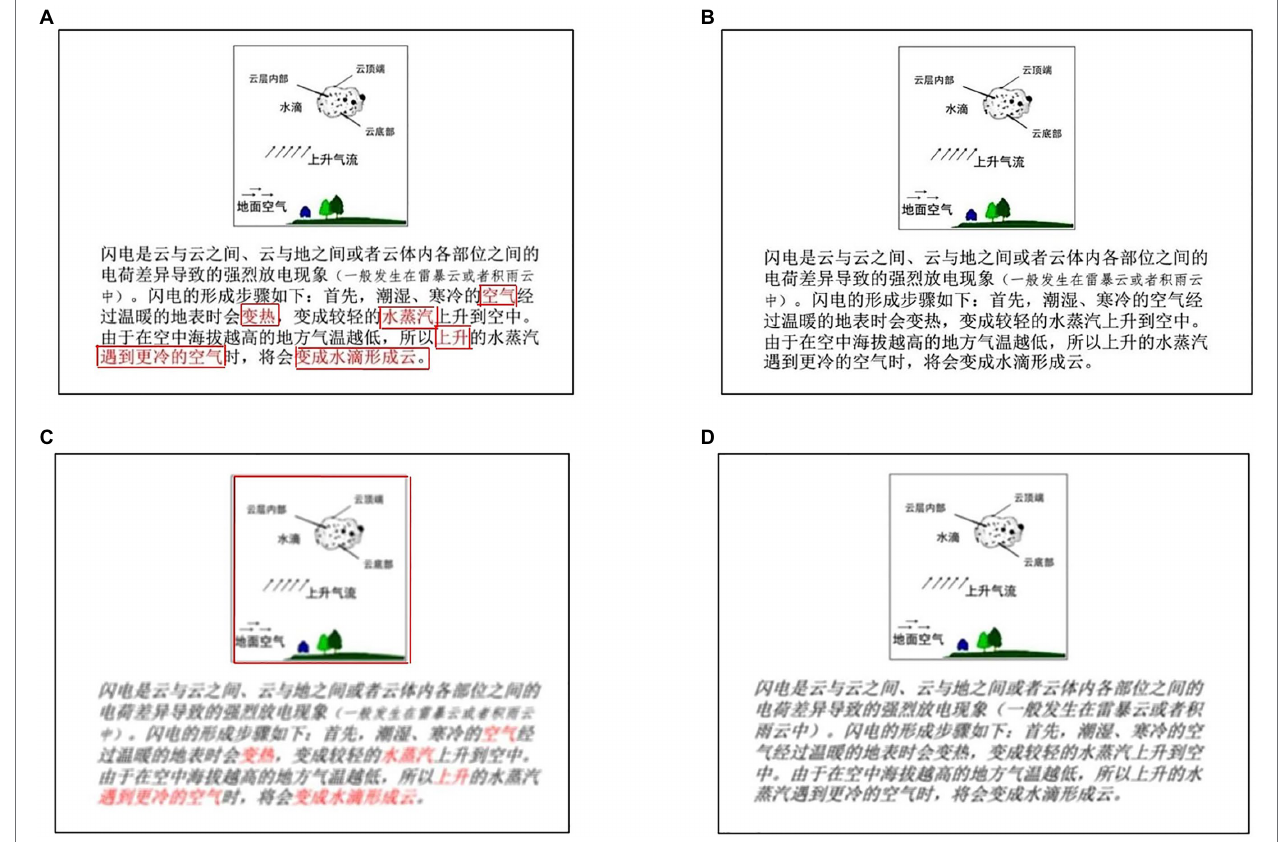
FIGURE 1 | The instructional materials for four experimental conditions. Specifically, (A) is the experimental conditions of signaling/fluency, (B) is non-signaling/ fluency, (C) is signaling/disfluency, and (D) is non-signaling/disfluency. And the red box on the upper left is the cue interest area, and the lower left is the interest area of the image area. There is no red box of interest areas in the actual experiment process.